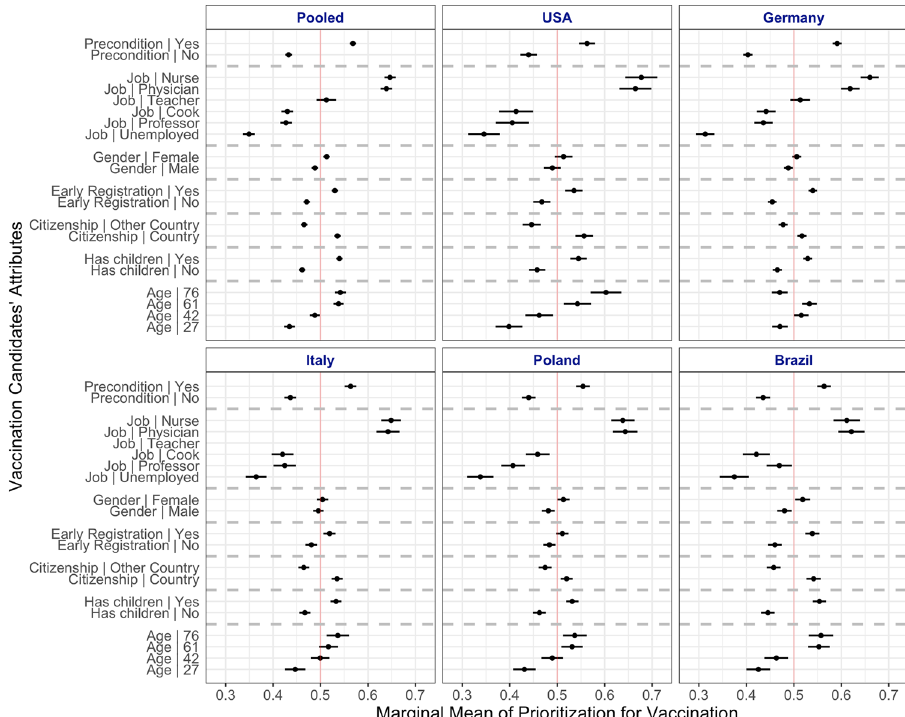
Fig. 3 Effects of vaccination candidates' attributes on the probability to be prioritized in conjoint task. Marginal means with 95% con fi dence intervals displayed for the fi ve countries and pooled